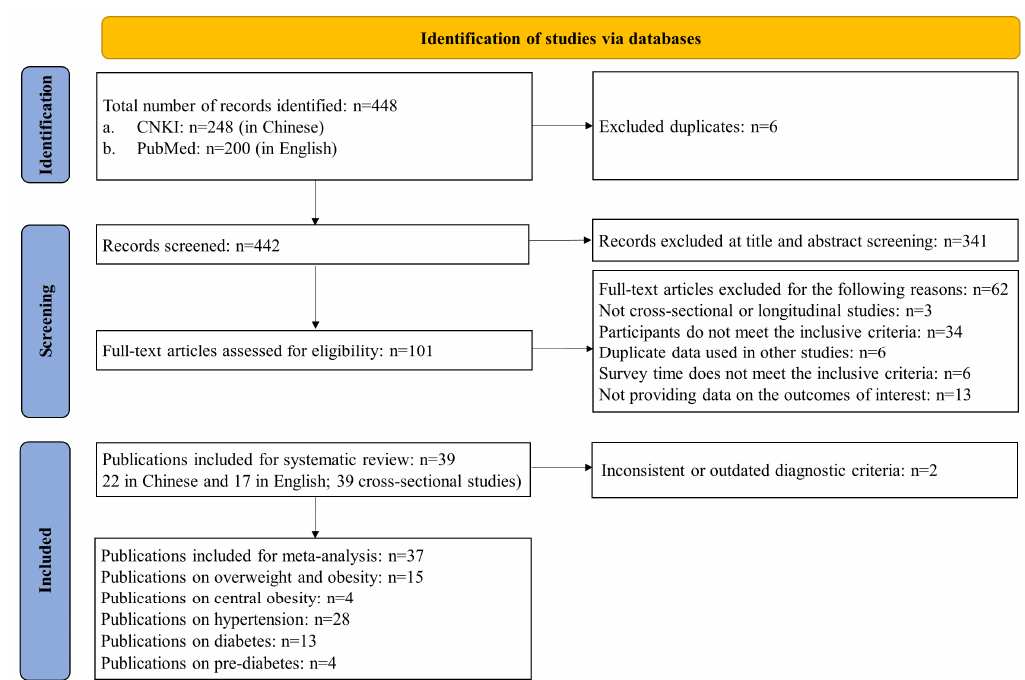
Figure 1. Flowchart of the literature search and study selection according to the PRISMA standard. Abbreviation: PRISMA, Preferred Reporting Items for Systematic Reviews and Meta-Analyses; CNKI: China National Knowledge Infrastructure.